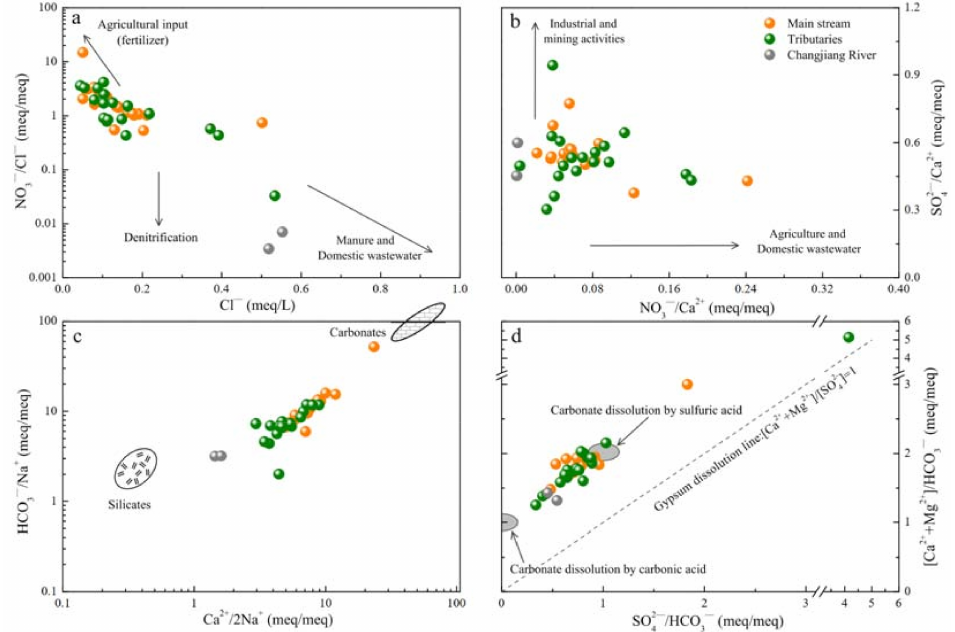
Figure 3. The relationship between Cl − and NO 3 − /Cl − ratios ( a ), NO 3 − /Ca 2+ ratios and SO 42 − /Ca 2+ ratios ( b ), Ca 2+ /2Na + ratios and HCO 3 − /Na + ratios ( c ), [Ca 2+ + Mg 2+ ]/HCO 3 − ratios and SO 42 − /HCO 3 − ratios ( d ) in Chishui River